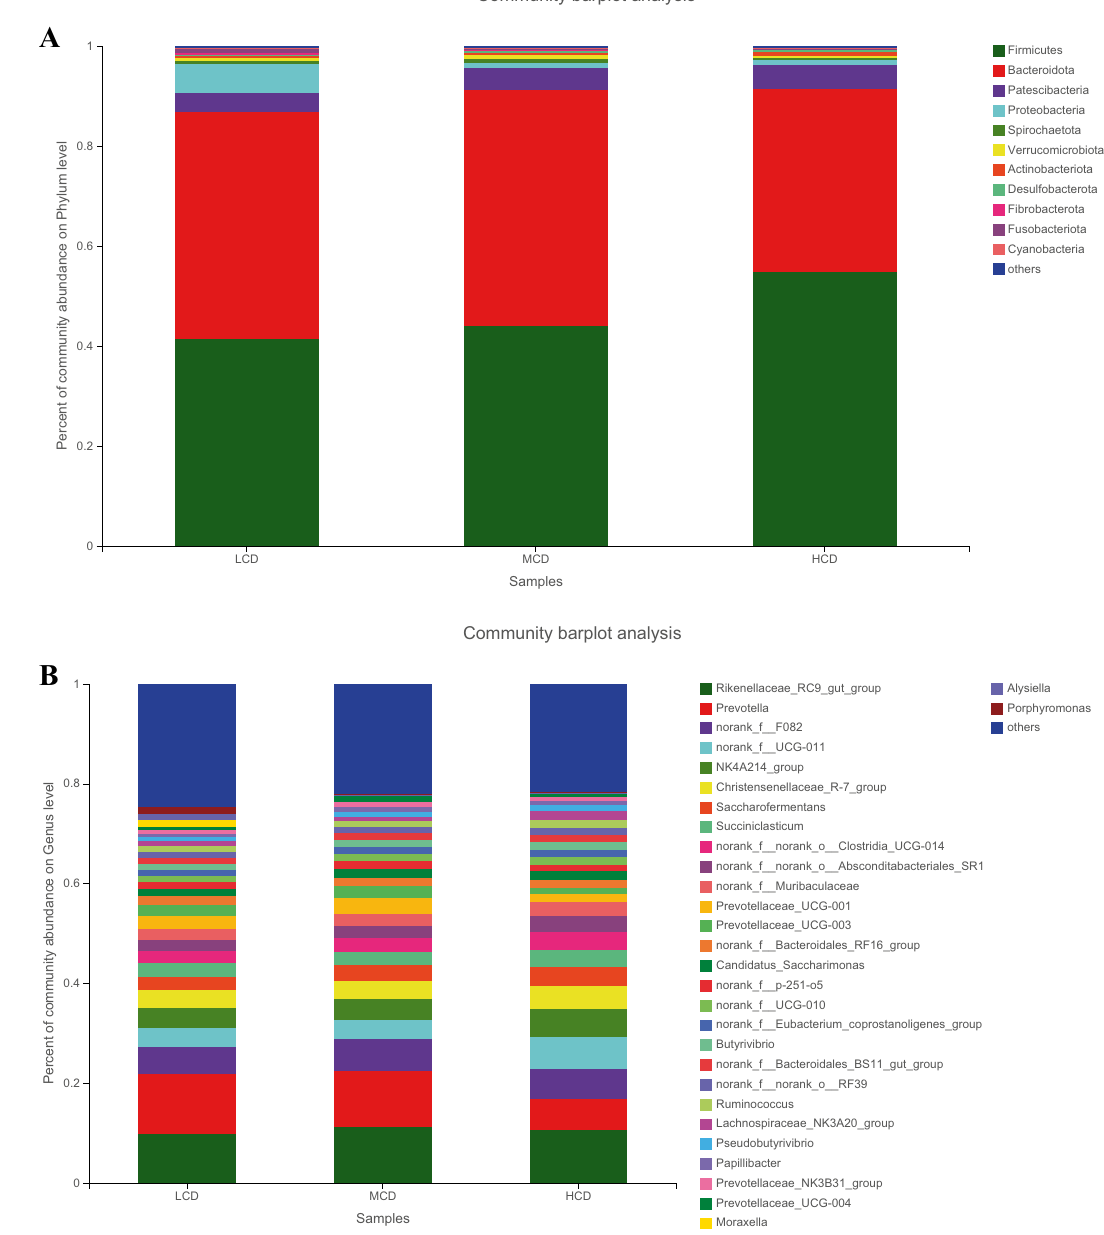
Figure 2. Phylum-level ( A ) and genera-level ( B ) composition of the rumen microbiome. Color-coded bar plot showing the average bacterial phylum or genera distribution across the different groups that were sampled. LCD, 35:65 concentrate:forage; MCD, 50:50 concentrate:forage; HCD, 65:35